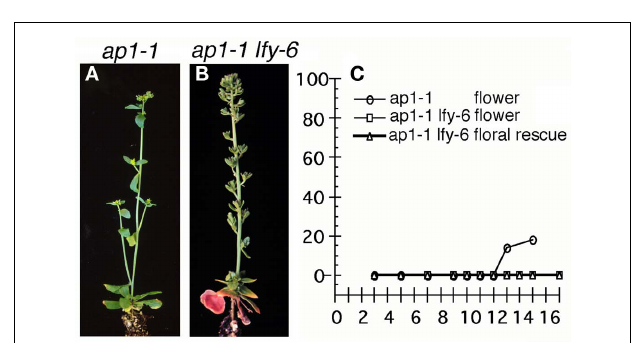
FIGURE 3 |Transient LFY activation in ap1-1 mutants. ap1-1 35SLFY-GR seedlings (A) or ap1-1 lfy-6 35SLFY-GR seedlings (B) treated as described in Figure 1 .Very few inflorescence to flower conversions were observed. (C) The ratio of plants exhibiting a given response over the total number of plants per treatment day (% response). For each treatment day 20–30 plants were scored after bolting. ap1-1 plants were scored for inflorescence to flower conversion ( ). ap1-1 lfy-6 plants were scored for inflorescence to flower conversion ( ) and floral rescue ( ).